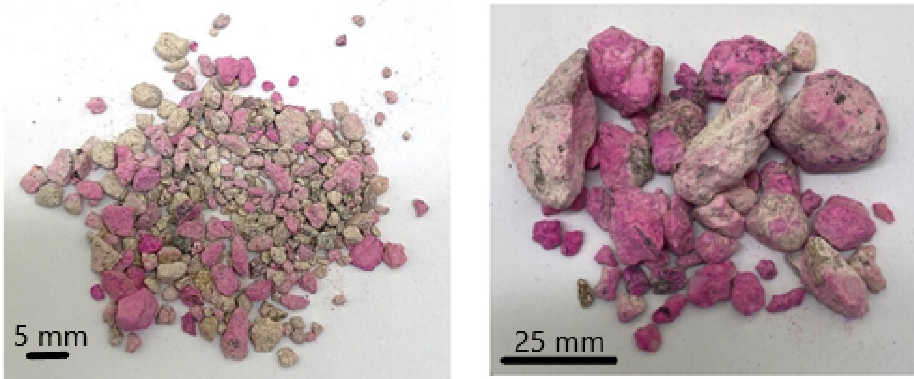
Figure 2. Sieve curves of recycled gravel before and after carbonation according to the two pro- cesses; d is the sieve size (passing).